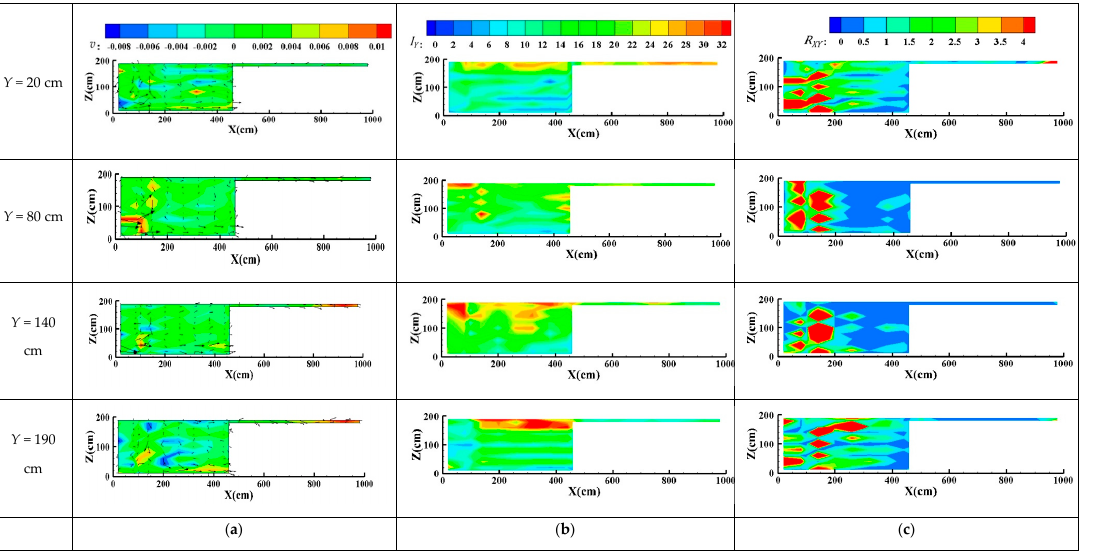
Figure 5. Distribution of transverse flow characteristics: ( a ) velocity (the contour plot represents the transverse velocity v , and the vector represents velocity u - w ); ( b ) dimensionless turbulence intensity I Y ; and ( c ) dimensionless Reynolds shear stress R XY . (The unit of velocity is m / s, and the dimensionless turbulence intensity and dimensionless Reynolds shear stress is